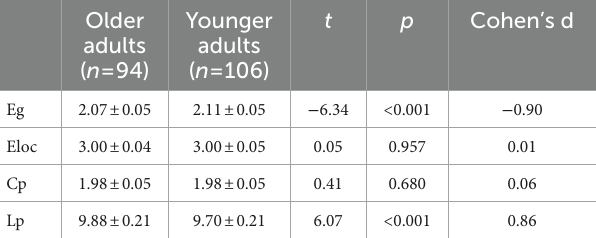
TABLE 5 Comparisons of global topological properties between groups (×10 − 1 ). Older